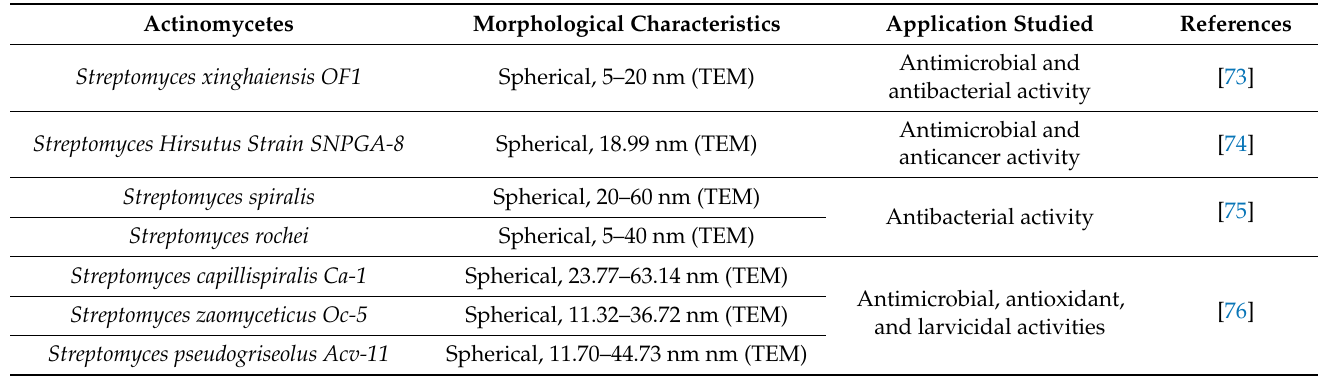
Table 2. Actinomycetes-mediated synthesis of AgNPs, their morphological characteristics, and their